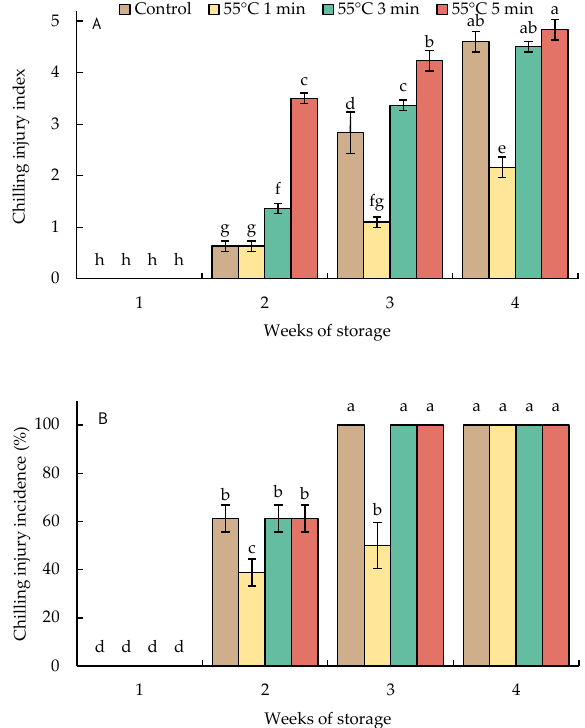
Figure 1. Effect of hot water treatment (55 ◦ C for 1, 3, 5 min) on ( A ) chilling injury index and ( B ) chilling injury incidence in red sweet pepper fruit during storage at 10 ◦ C. Data represent means ± S.E. (n = 3). Different letters on bars are significantly different ( p < 0.05).